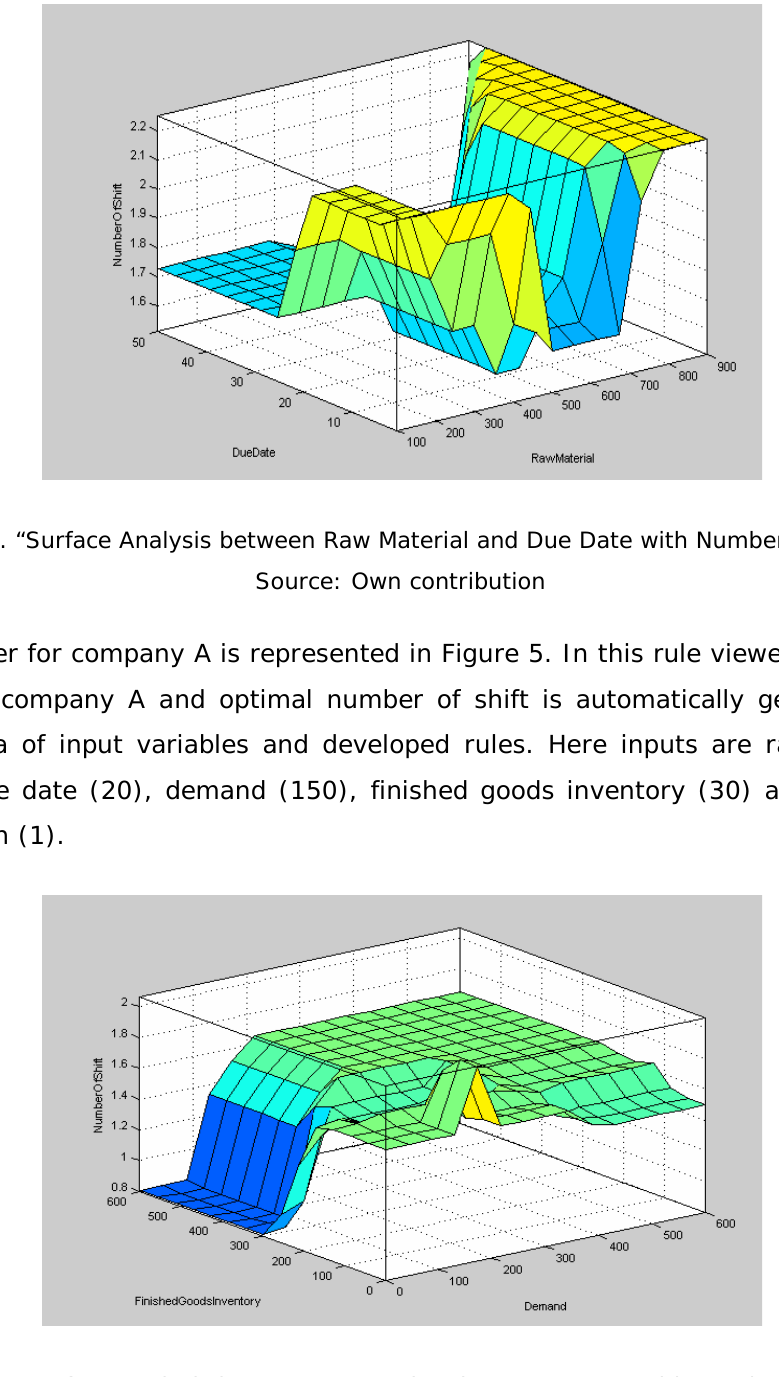
Figure 7. “Surface Analysis between Demand and F/G Inventory with Number of Shift”. Source: Own